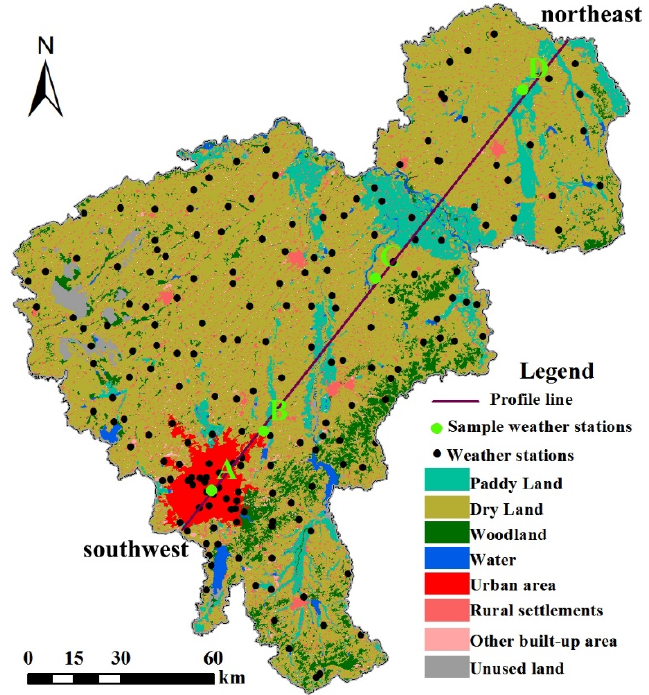
Figure 3. The southwest-northeast profile and the spatial pattern of land use. Table 2. Area (km 2 ) and percentage (%) of different land use types for the study area.